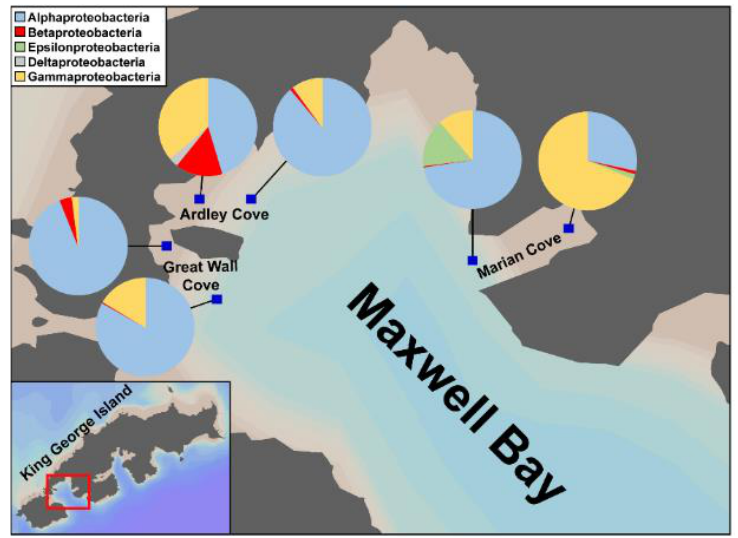
Figure 6. Comparison of bacterial community composition in Antarctic Ardley, Great Wall, and Marian Coves. Pie charts show the relative abundance of bacterial communities at the class level (associated with the phylum level of Proteobacteria) at each location (blue squares). Note that the Ardley and Great Wall Coves data are reproduced from the results of previous study [20] and the Marian Cove data are from the results of this study.